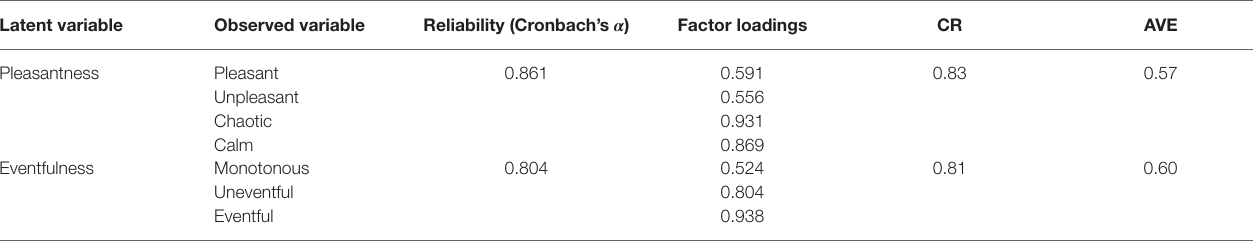
TABLE 3 | Results of confirmatory factor analysis (CFA) for scale reliability and construct validity ( N =